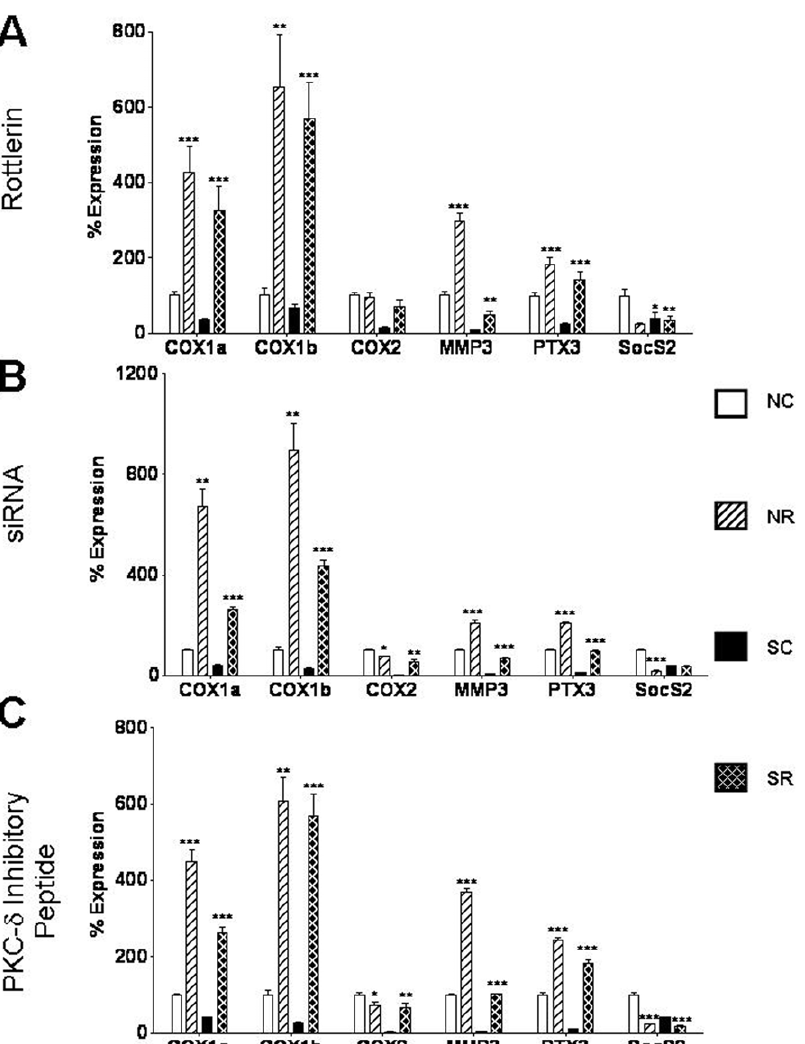
Figure 7. Validation of expression levels of genes downregulated in SSc fibroblasts compared to normal fibroblasts following PKC- d inhibition. mRNA expression levels of 6 downregulated genes in normal and SSc human dermal fibroblasts following treatment with A. 5 m M rottlerin, B. 10 nM PKC- d siRNA, C. 10 m M cell permeable specific PKC- d inhibitory peptide for 24 h. Results are expressed as mean percent difference + / 2 SD of 3 replicate samples analyzed by quantitative RT-PCR. The PBS control was arbitrarily set to 100% expression. NC: Normal untreated fibroblasts, NR: Normal treated fibroblasts, SC: SSc untreated fibroblasts, SR: SSc treated fibroblasts. Statistical significance was calculated to compare treated vs untreated normal or SSc fibroblasts. *: p , 0.1; **: p , 0.01; ***: p ,